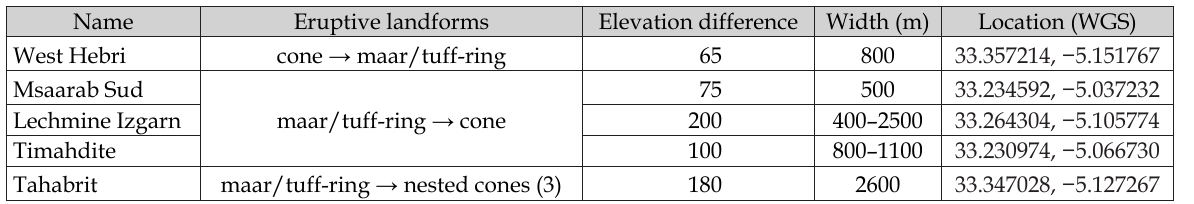
Table 3. Classification table of eruptive mixes according to their eruptive landforms, elevation’s difference, width, and the geographic